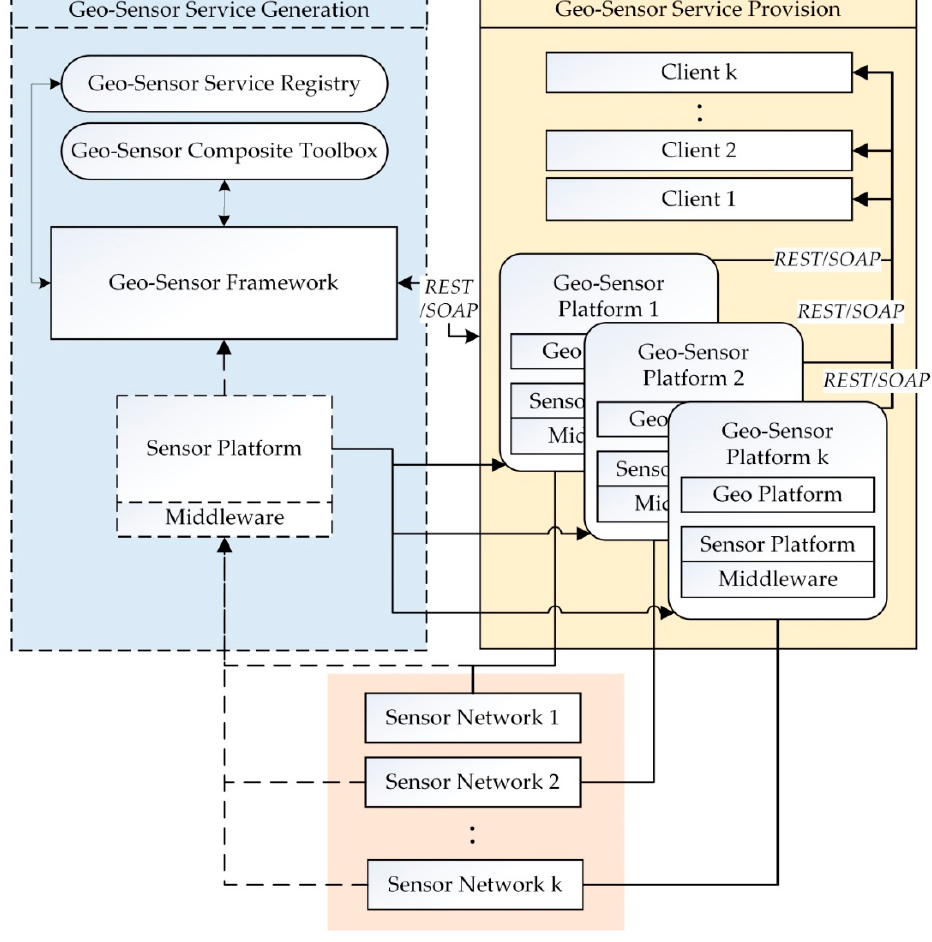
Figure 2. Geo-sensor framework conceptual diagram for multi-platforms.